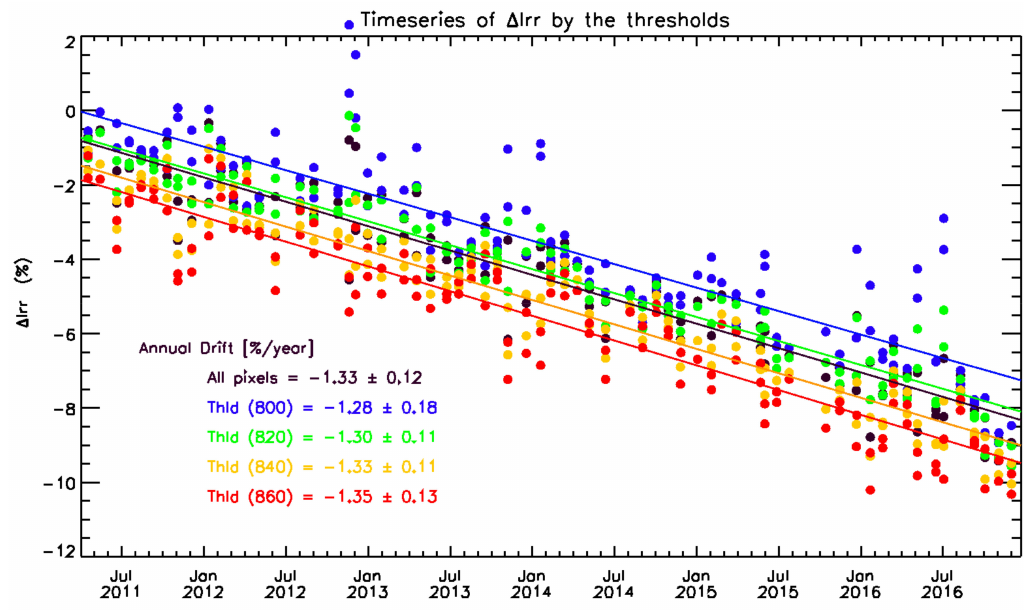
Figure A2. Degradation ratios for threshold values used in selected Moon image